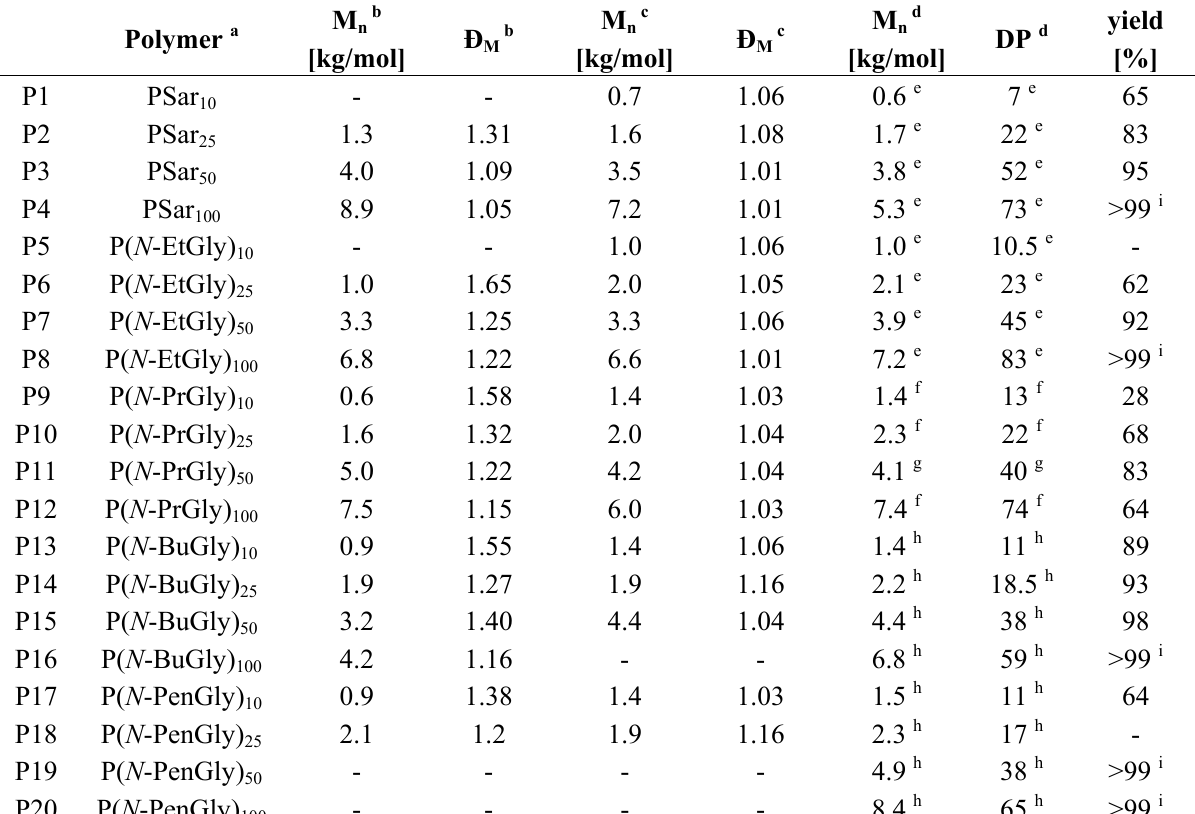
Table 2. Analytical data of synthesized